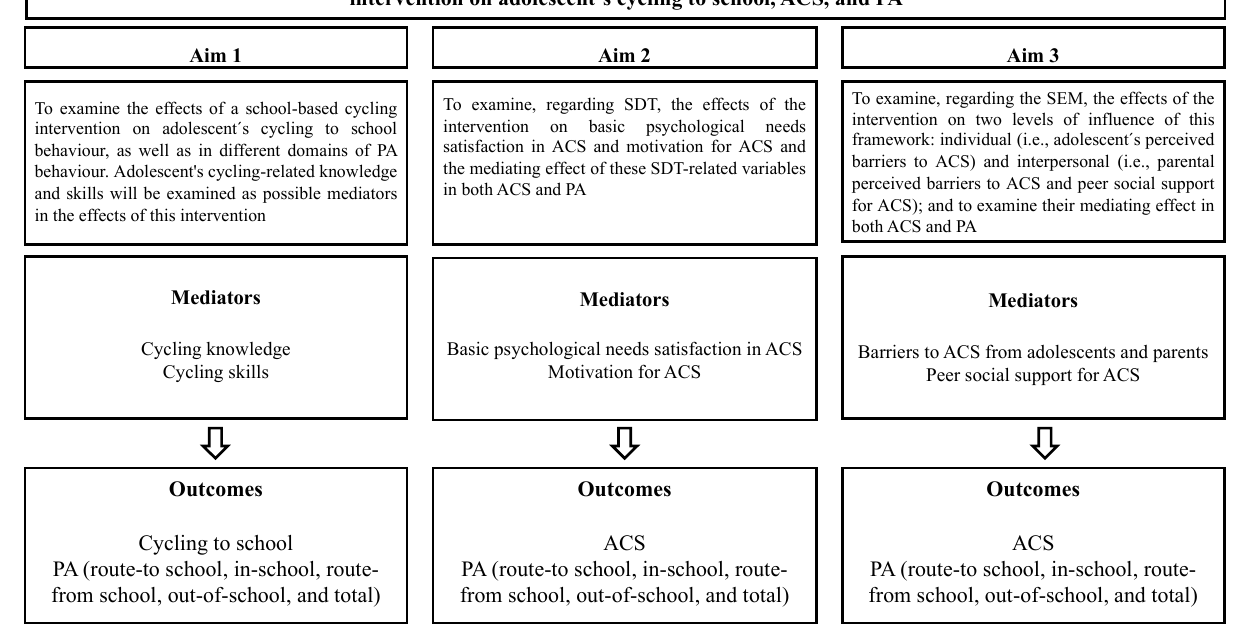
Figure 1. The “Pedalea y Anda al COle” (PACO) study logic model. Note: RCT: randomized controlled trial; ACS: active commuting to and from school; PA: physical activity; SDT: self-determination theory; SEM: social-ecological model; RE-AIM: reach, effectiveness, adoption, implementation, maintenance.